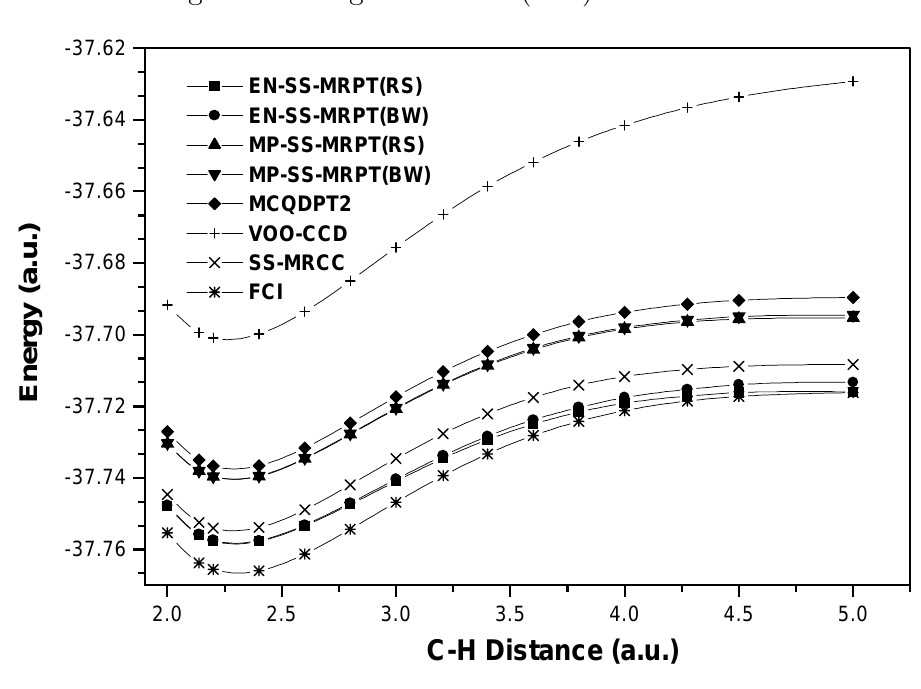
Figure 1: The ground state ( 1 Σ + ) PES of CH +